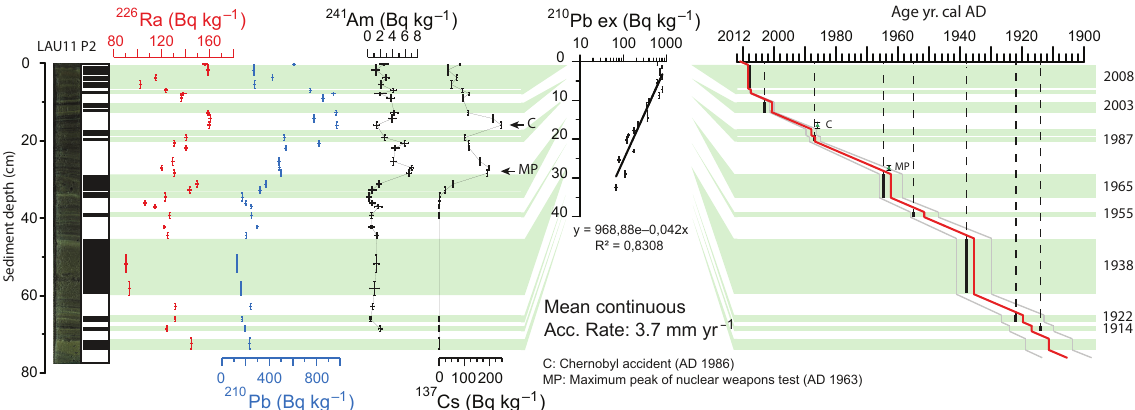
Figure 4. 226 Ra, 210 Pb, 241 Am, and 137 Cs activity profiles for core LAU11P2. Application of the CFCS model to the synthetic sedimentary profile of excess 210 Pb (without normally graded beds, which are considered to be instantaneous deposits). Resulting age–depth relationship with 1 σ uncertainties and indications of historic flood dates associated with normally graded beds and the two artificial radionuclide markers.